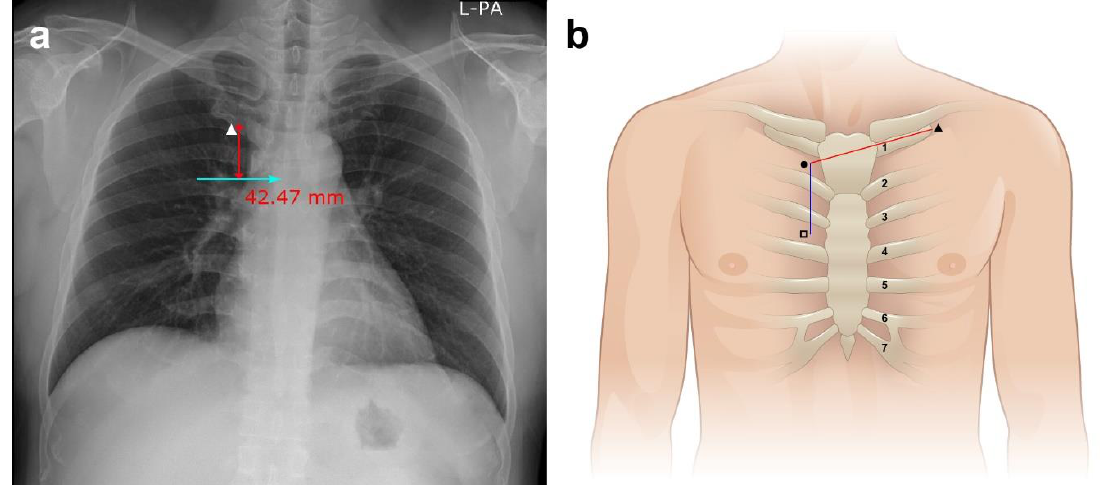
Figure 1. Radiological and topographical landmarks. ( a ) Chest radiograph for measuring the distance between the first intercostal space and the carina. The distance from the right first intercostal space to the carina is measured as the vertical length between the lower border of the right first costal cartilage (solid triangle) close to the sternum and a horizontal line connecting it to the carina using an electronic caliper in the radiological group. ( b ) Schematic illustration for estimating the distance from the venous insertion point through the right first intercostal space to the right third intercostal space in the topographical group. The distance is determined by adding the distance between the venous insertion point (solid triangle) and the midpoint of the right first intercostal space (solid circle) just lateral to the sternal angle, and the distance between the midpoints of the first and third intercostal spaces (open square) just lateral to the sternum as measured on the skin surface.